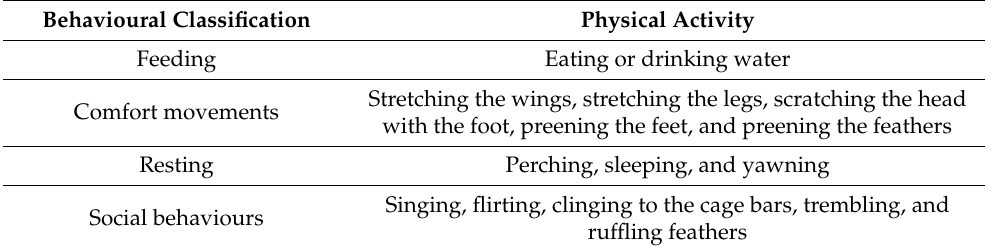
Table 3. The ethogram used to observe the behaviours of budgerigars in their cages.